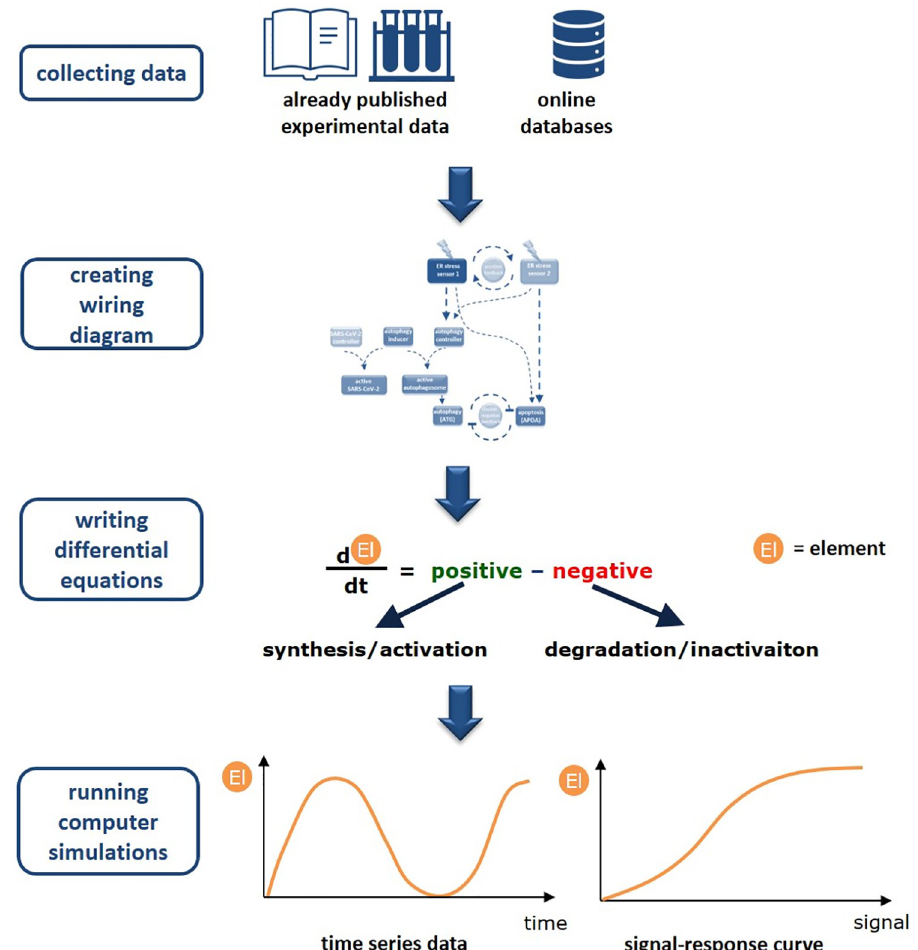
Fig 1. The schematic picture of our workflow. The modelling approach we present here is based on existing experimental data, either from the published papers or from databases containing referenced information. We use this data to create a static wiring diagram and differential equitations to capture the dynamics of the system. The models are then used to simulate the effect of the different elements ("El" for short).